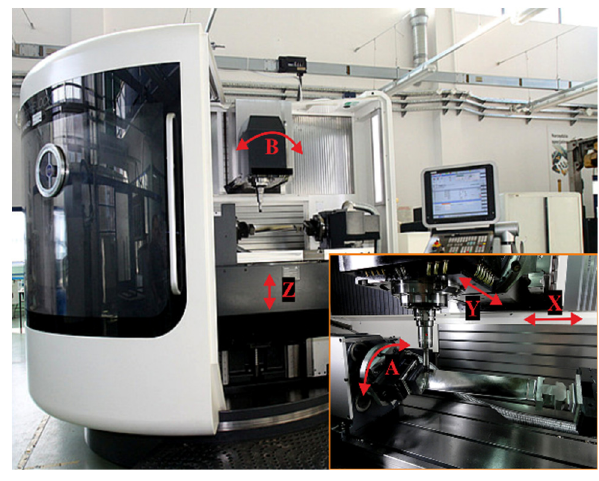
Figure 7. Test stand.